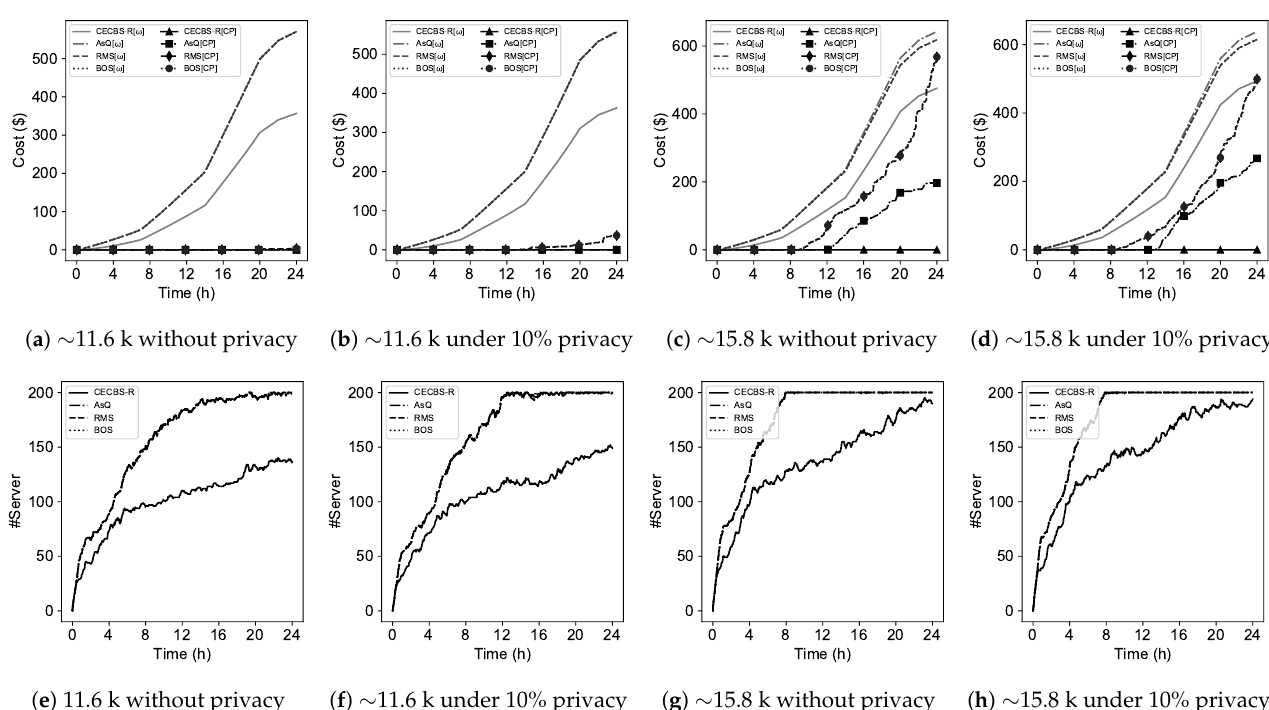
Figure 10. The accumulated edge ( ω ) and public cloud ( CP ) cost followed by the edge server usage for ∼ 11.6 k and ∼ 15.8 k jobs.